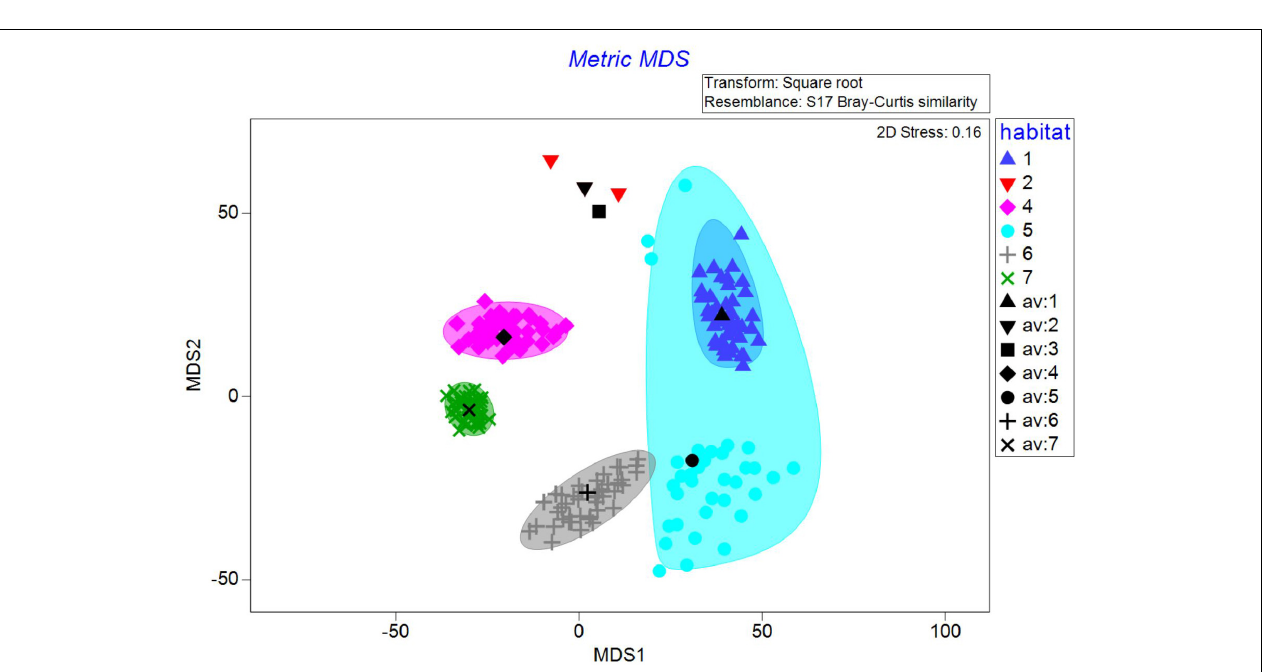
FIGURE 3 | Two-dimensional, metric multidimensional scaling plot showing ordination of benthic habitats based on bootstrapped values calculated for 43 replications per group. Bootstrap averages (colored symbols), group averages (black symbols) and 95% confidence intervals (colored ellipses) based on bootstrap sampling with replacement are also shown. 1, Infralittoral shelly coarse sand and shellbed with various infauna; 2, Infralittoral fine and medium sand dominated by Chamelea gallina ; 3, Infralittoral muddy sand with Upogebia pusilla ; 4, Circalittoral mud and sandy mud with Upogebia pusilla ; 5, Circalittoral shelly coarse sediment with various infauna; 6, Circalittoral mixed sediments with various infauna and mussel beds; 7, Circalittoral mud with Spisula subtruncata .